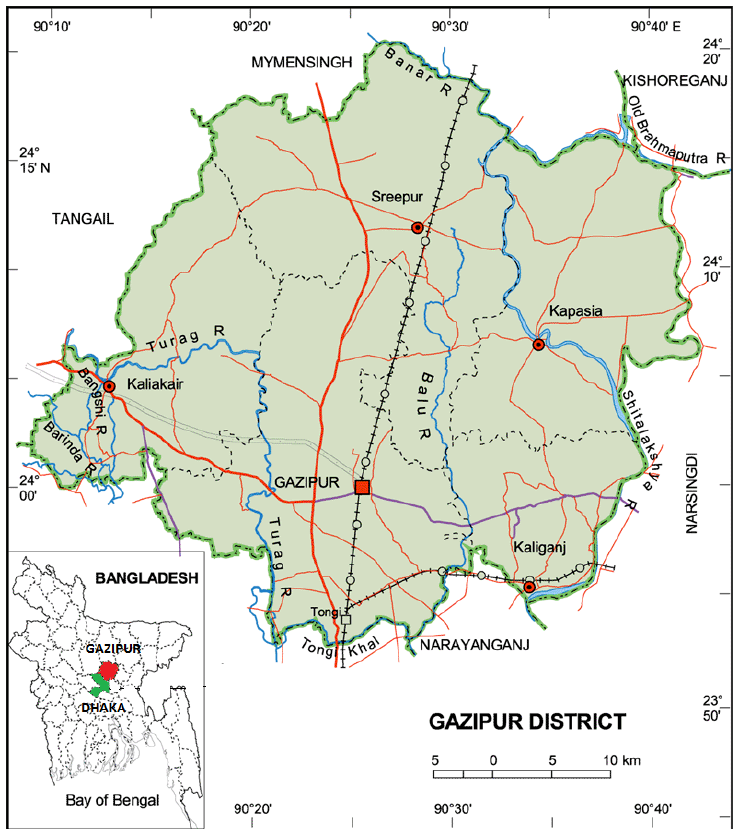
Source: GIS Section, BANGLAPEDIA, Asiatic Society of